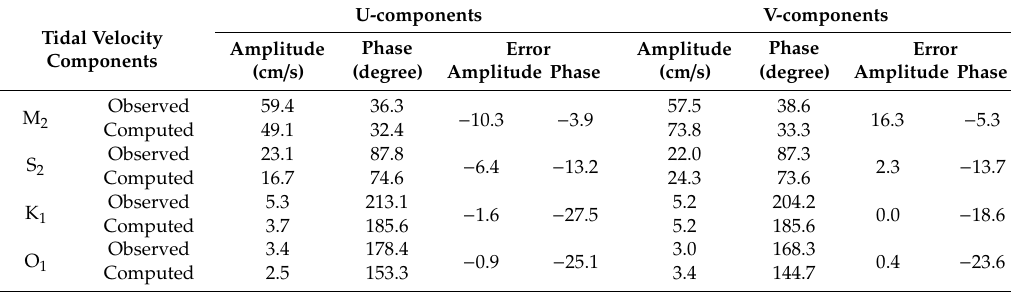
Table 3. Comparison of observed and computed tidal velocity harmonic constants for M 2 , S 2 , K 1 , and O 1 at C-2.